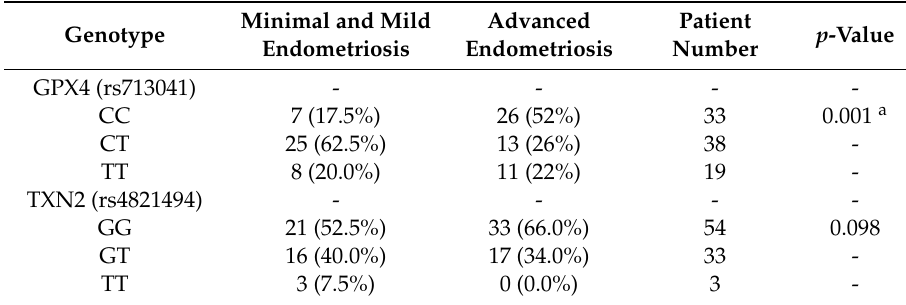
Table 5. The di ff erence of allele frequency between the stage of endometriosis with the corresponding single nucleotide polymorphism in GPX4 and TXN2